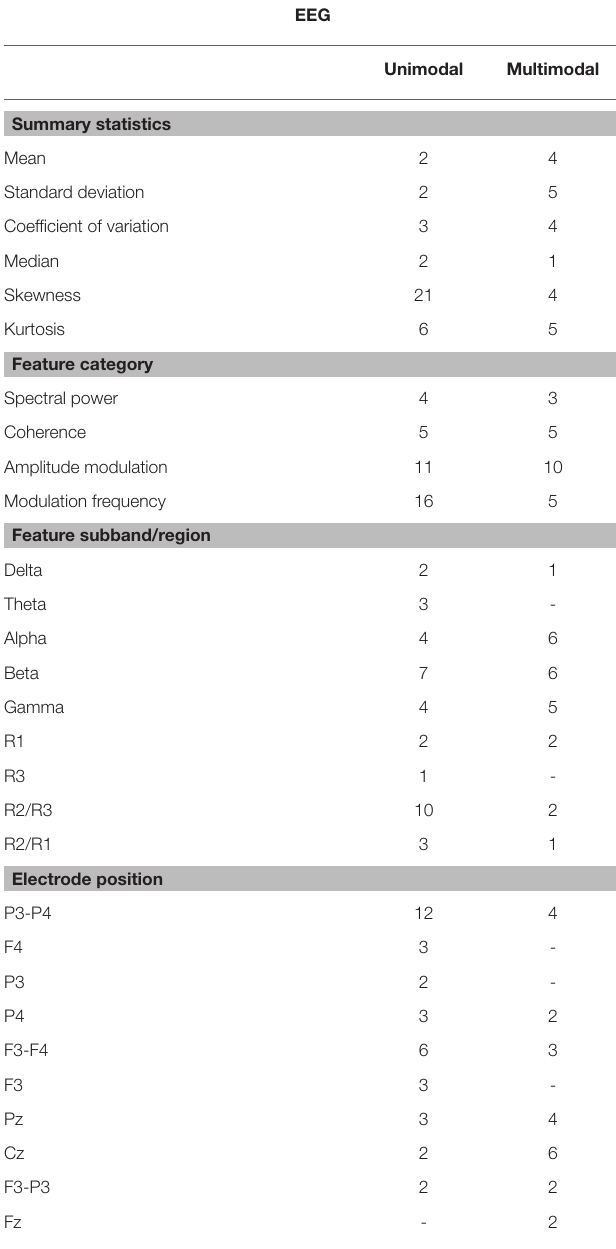
TABLE 5 | Distribution of the selected features that were selected in multiple runs for MRI